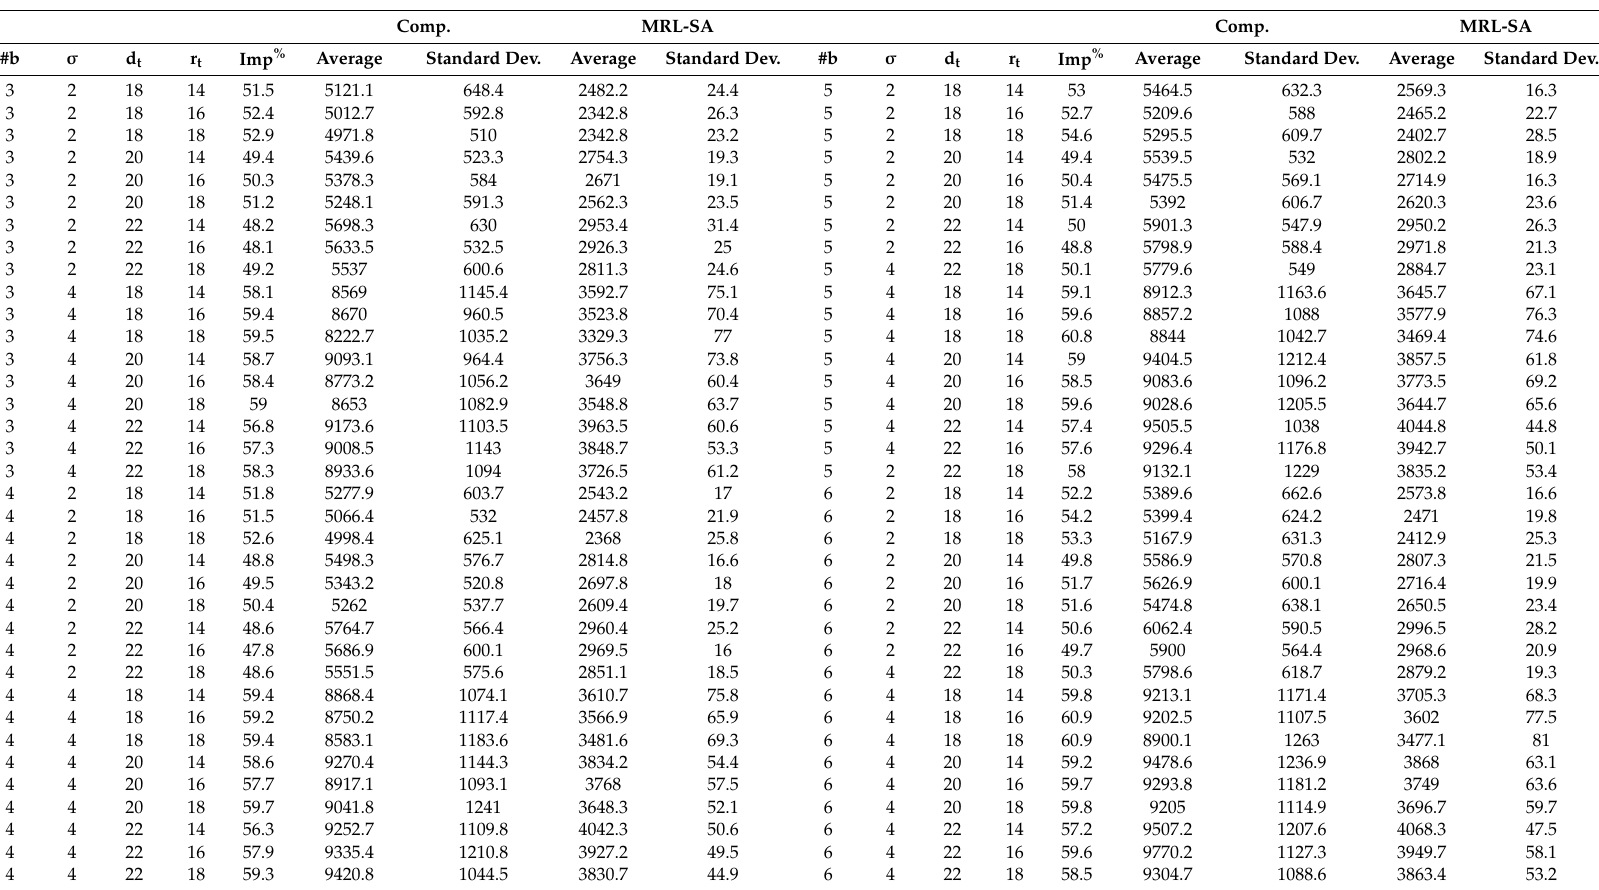
Table 6. Comparison of the proposed MRL-SA with less deviation than the composite method at the backlogging case using Lean Planner System